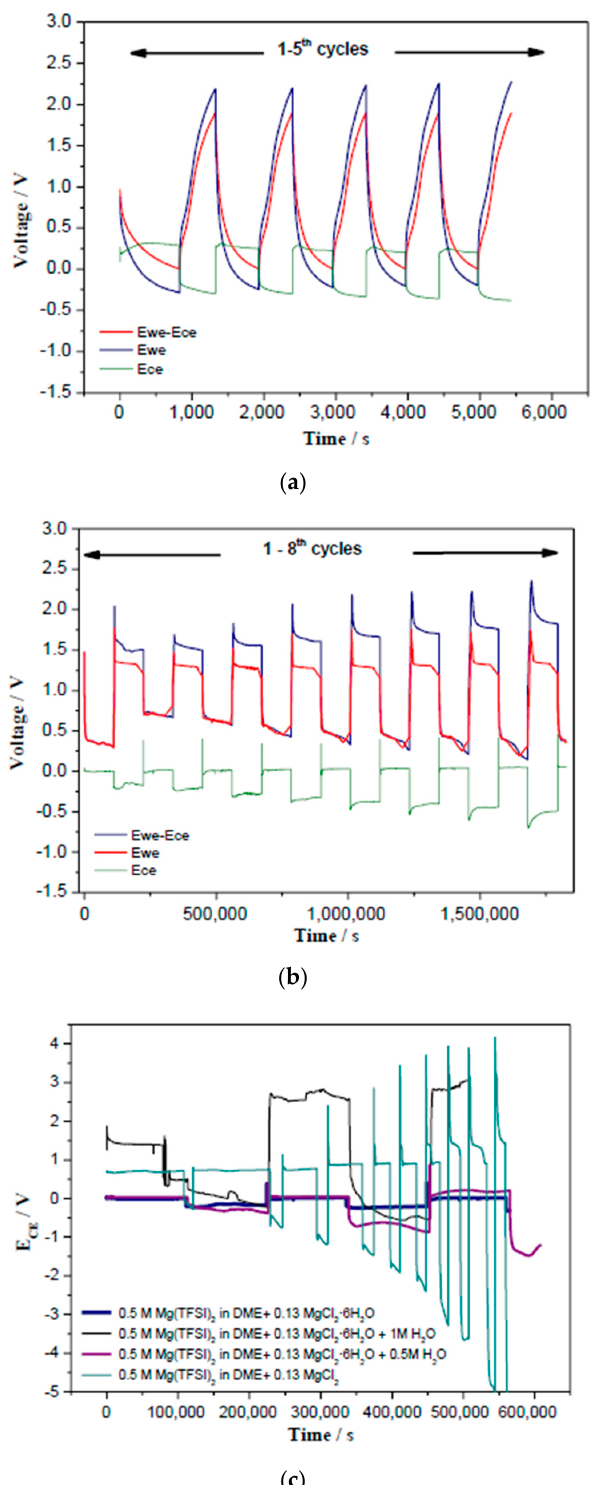
Figure 5. Voltage profiles (E CE , E WE and E WE -E CE ) of LTO versus time in a three electrode Mg cell using different electrolytes: ( a ) 0.5 M Mg(TFSI) 2 in DME, ( b ) 0.5 M Mg(TFSI) 2 + 0.13 M MgCl 2 ·6H 2 O in DME. ( c ) A comparison of E CE versus time of Mg/LTO cell in four different electrolytes containing different amount of water. Note: E CE , E WE and E WE -E CE refers to the potential of the counter electrode, working electrode and the difference between them, respectively.